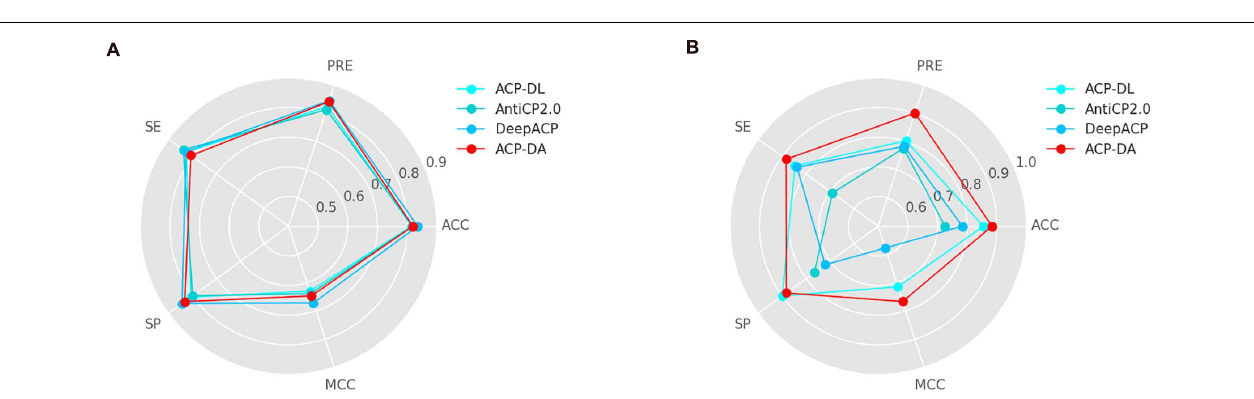
FIGURE 5 | Comparison of ACP-DA with existing methods on (A) ACP740 and (B)